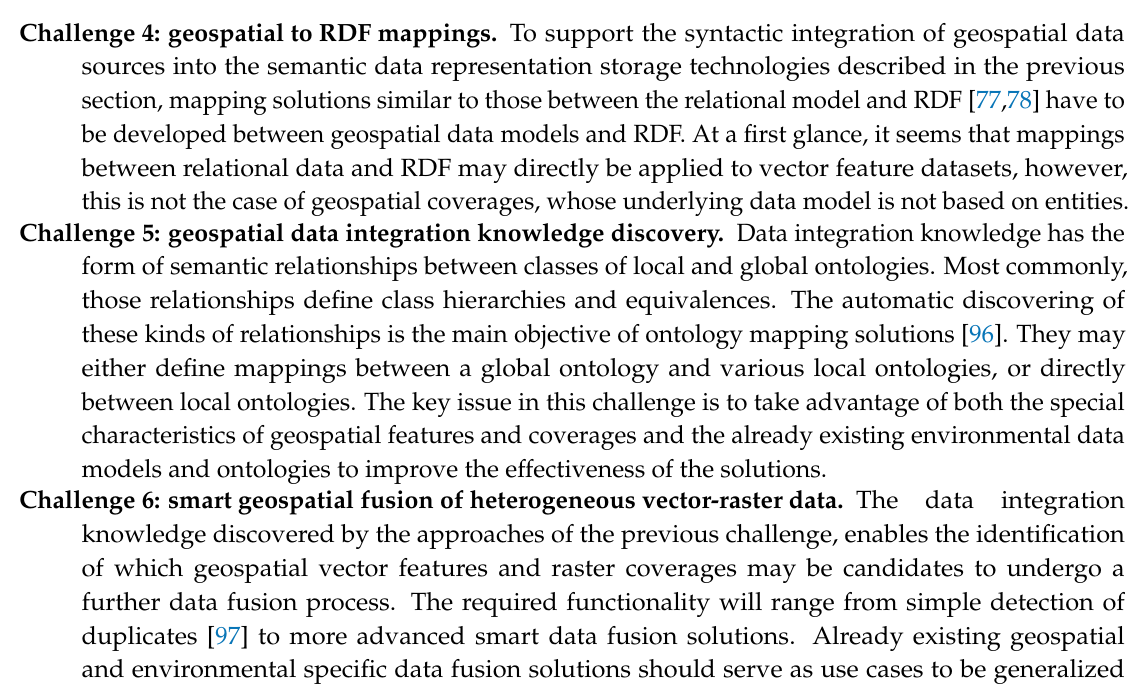
Figure 9. Illustration of challenges towards smart environmental data